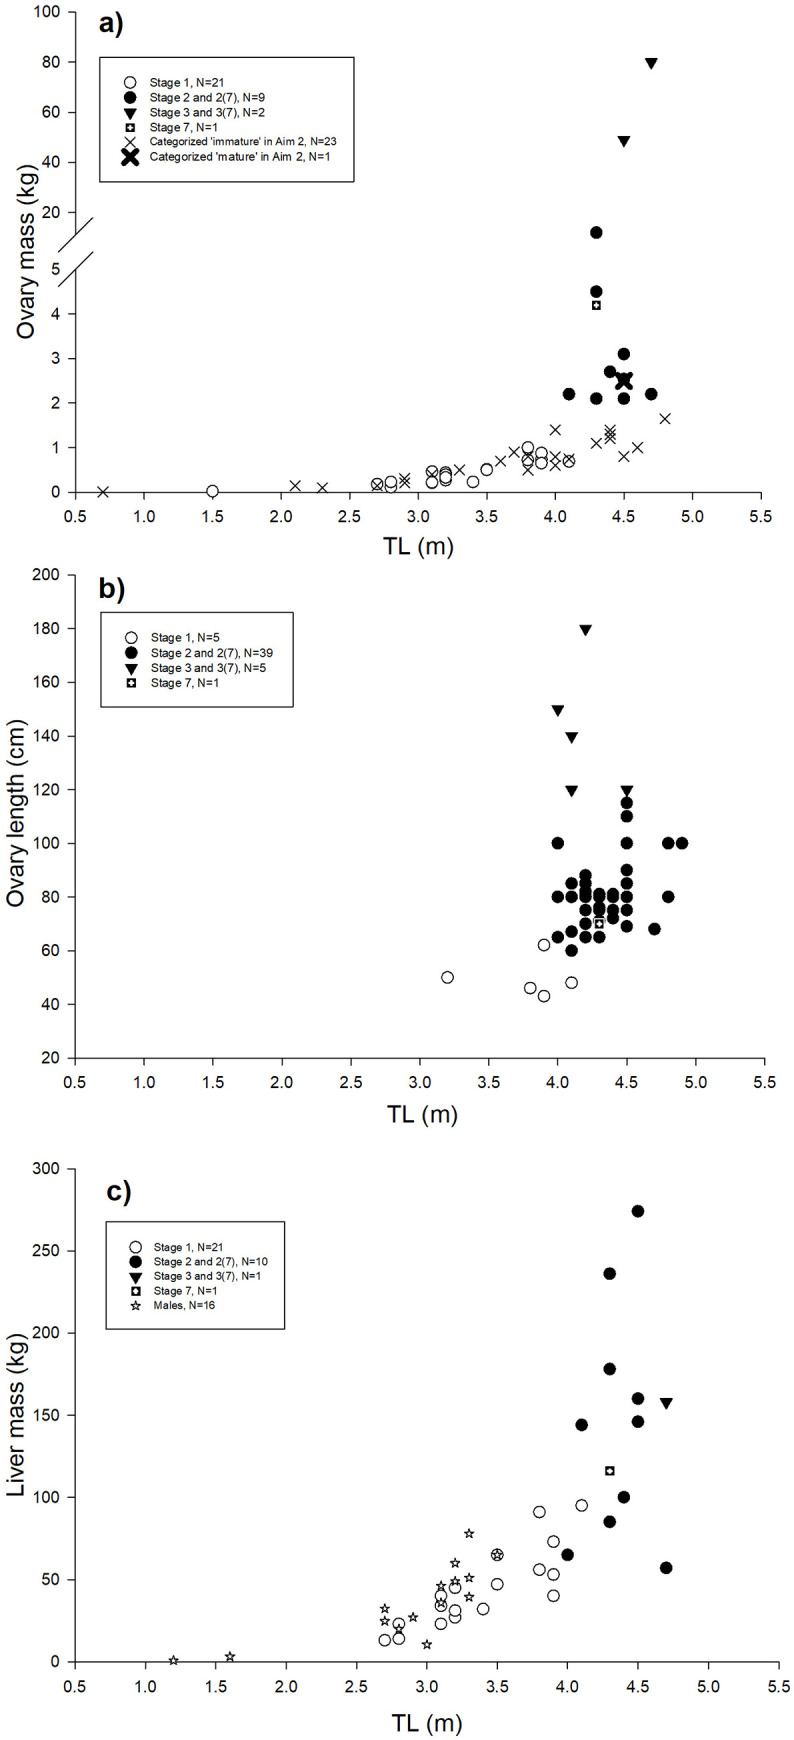
Reproductive parameters for females.(a) ovary mass, (b) ovary length, and (c) liver mass against TL and maturation stage. Note the break on y-axis in panel a and the inclusion of male liver mass in panel c.